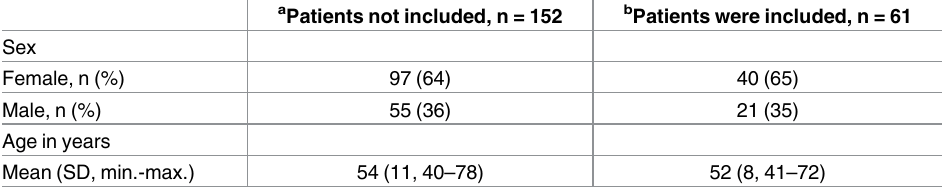
Table 1. Age and sex of patients with diabetes included and those who were not included in the dia- betic retinopathy study. a Patients not included, n = 152 b Patients were included, n =